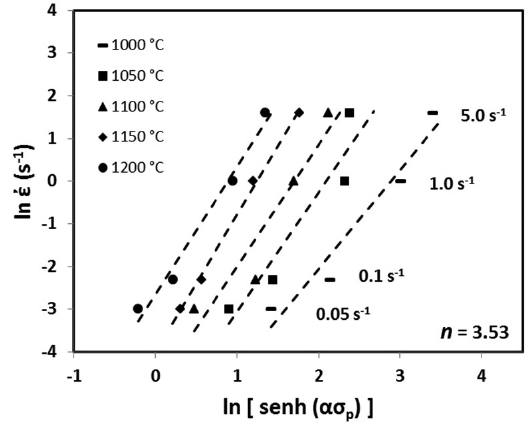
Figure 2. Procedure used to determine the value of n from Equation 9.